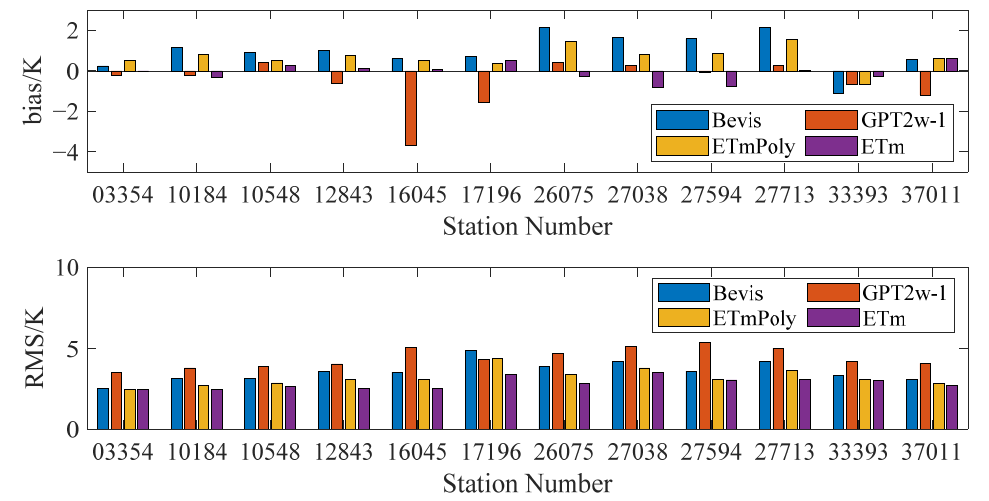
Figure 8. Results of the bias and RMS of the four Tm models at 12 non-modeling radiosonde stations